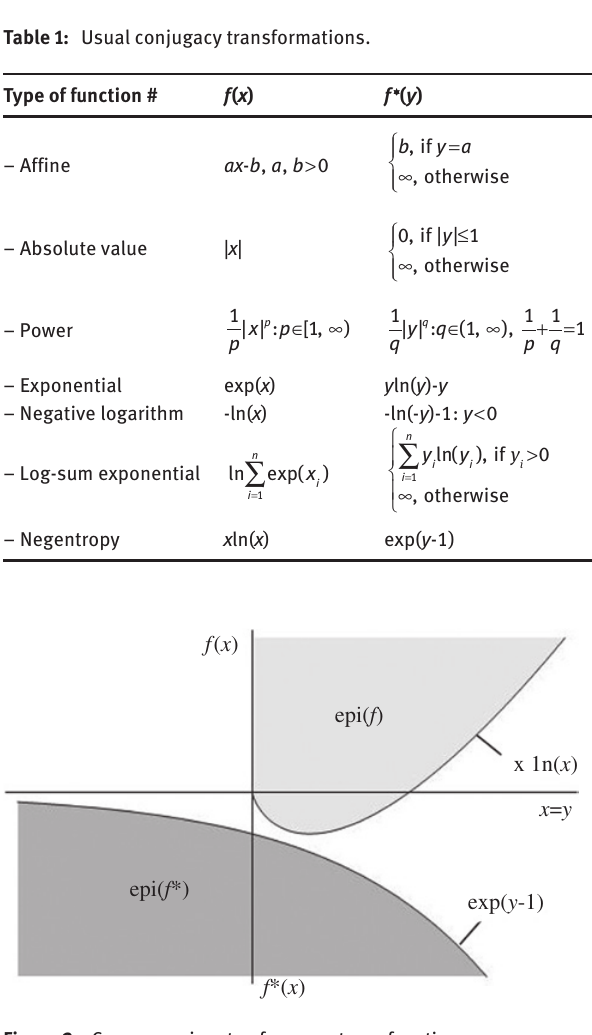
Figure 2: Convex conjugate of a negentropy